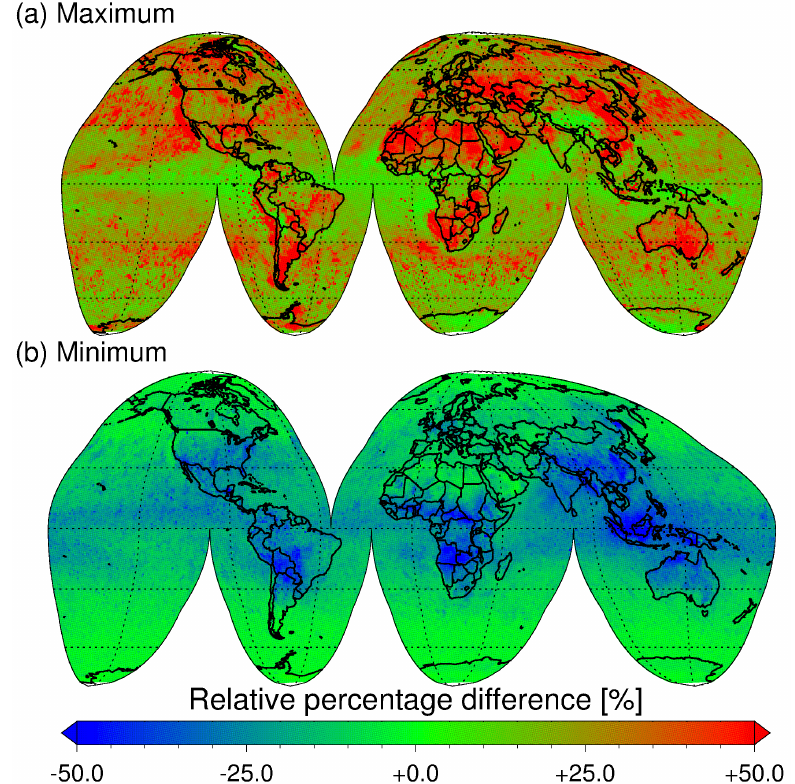
Fig. 4. Global distributions of (a) maximum and (b) minimum relative difference between retrieved and a priori CO at surface.